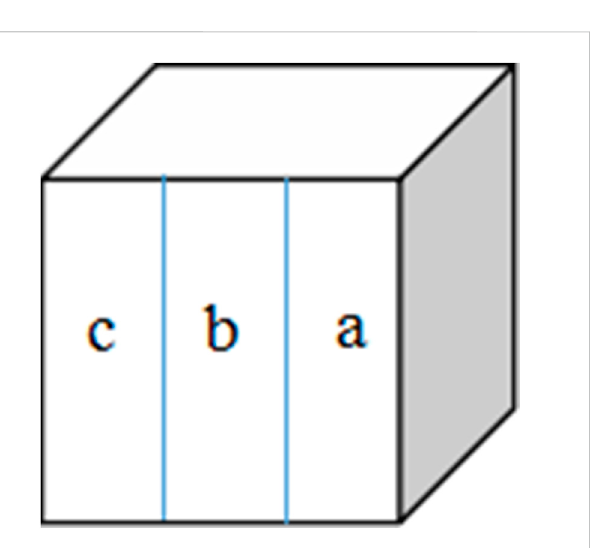
FIGURE 3 Specimen from the labial surface. Window (a) intact enamel reference, window (b) baseline caries, and window (c) test